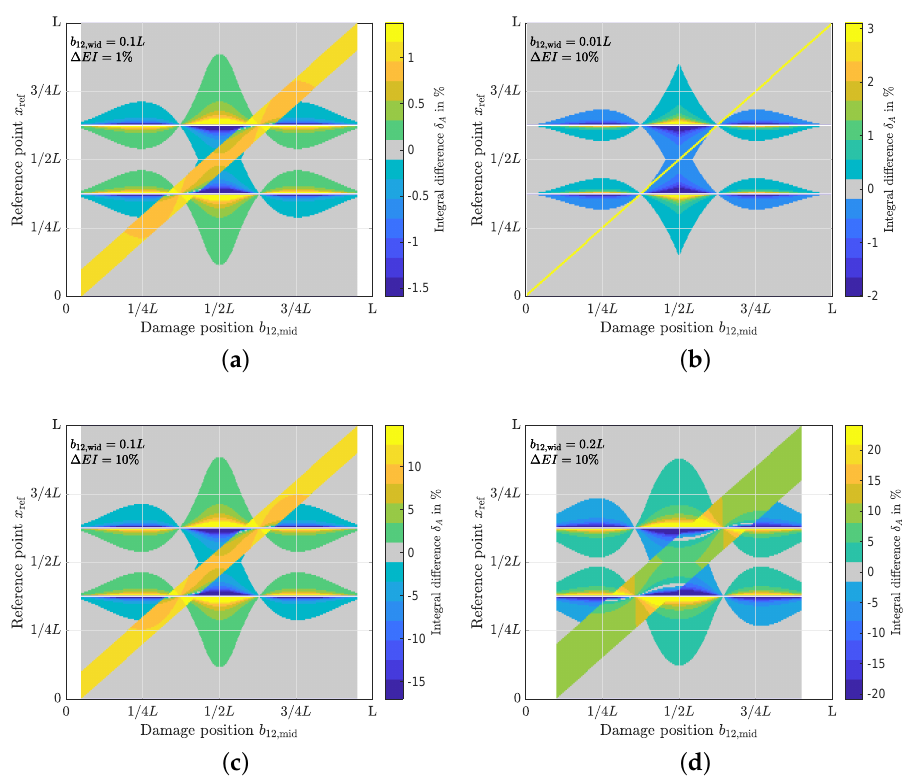
Figure 5. Contour plots for the relative integral difference of the curvature influence line η w (cid:48)(cid:48) . The relative integral difference is shown in colour. The damage location b 12,mid is plotted on the abscissa and the reference point x ref is plotted on the ordinate. ( a ) b 12,mid = 0.1 L and ∆ EI = 0.01. ( b ) b 12,mid = 0.01 L and ∆ EI = 0.1; ( c ) b 12,mid = 0.1 L und ∆ EI = 0.1; ( d ) b 12,mid = 0.2 L und ∆ EI =